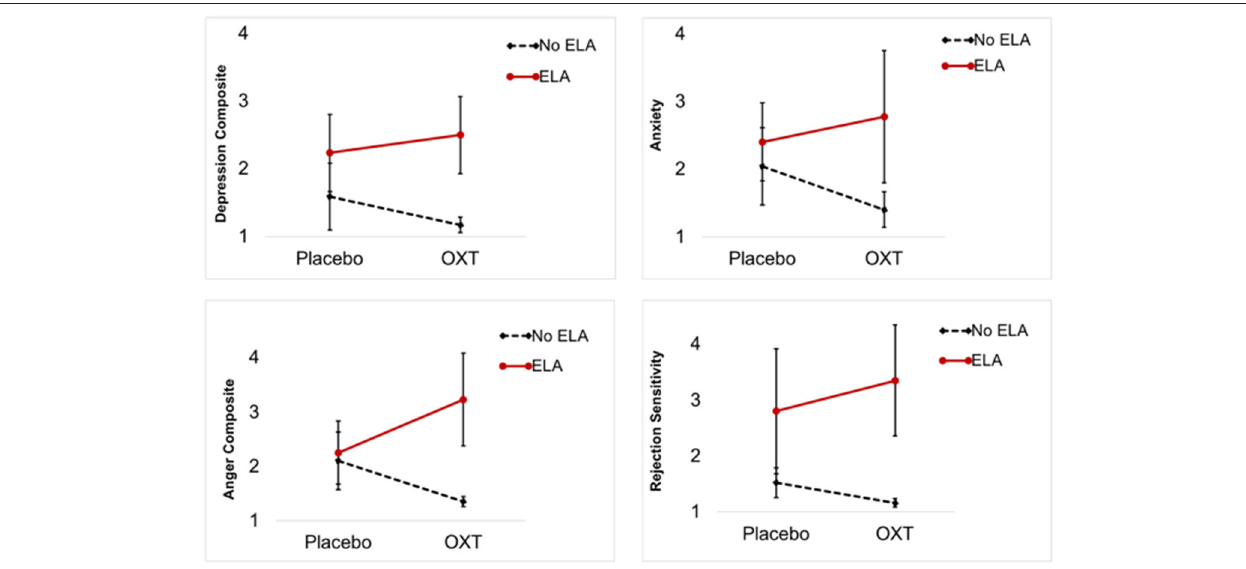
FIGURE 1 | Premenstrual symptom means and standard deviations by ELA group and experimental condition (OXT, Placebo). Each graph illustrates a significant interaction of OXT and ELA on premenstrual symptoms: OXT increased symptoms in PMDD women with ELA and decreased symptoms in PMDD women without